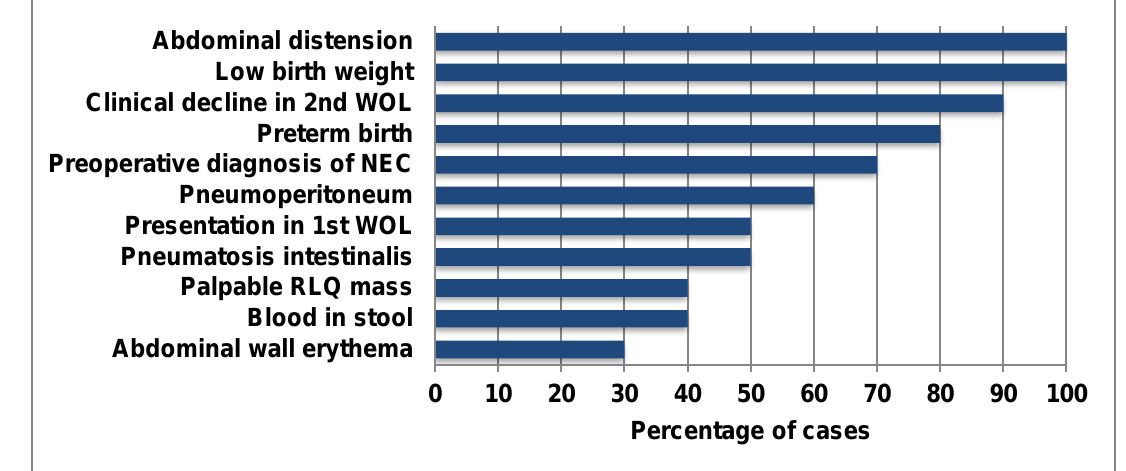
Figure 1: Patient characteristics from literature review WOL, week of life; RLQ, right lower